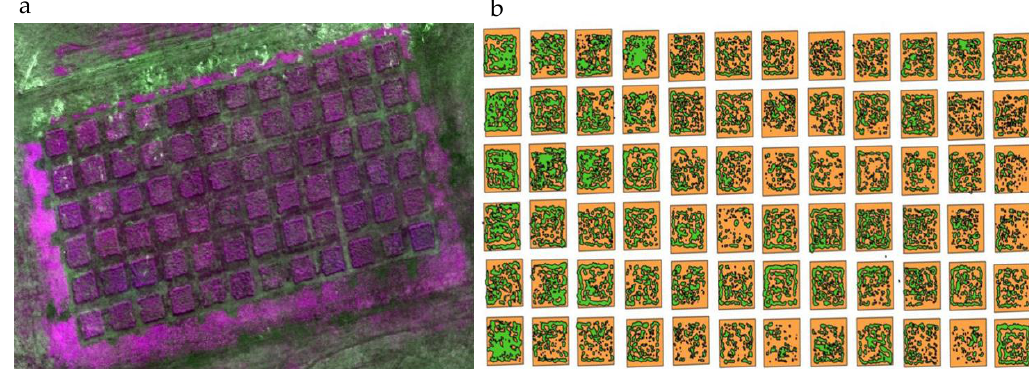
Figure 1. ( a ) Multispectral orthomosaic of the experimental site where Green, NIR, Red and Red edge multispectral bands converted to false colours composite to di ff erentiate individual plots; ( b ) the ground cover classification map in eCognition software package where green represents perennial ryegrass ground cover; orange represents soil and weed cover within the experimental plot boundaries.